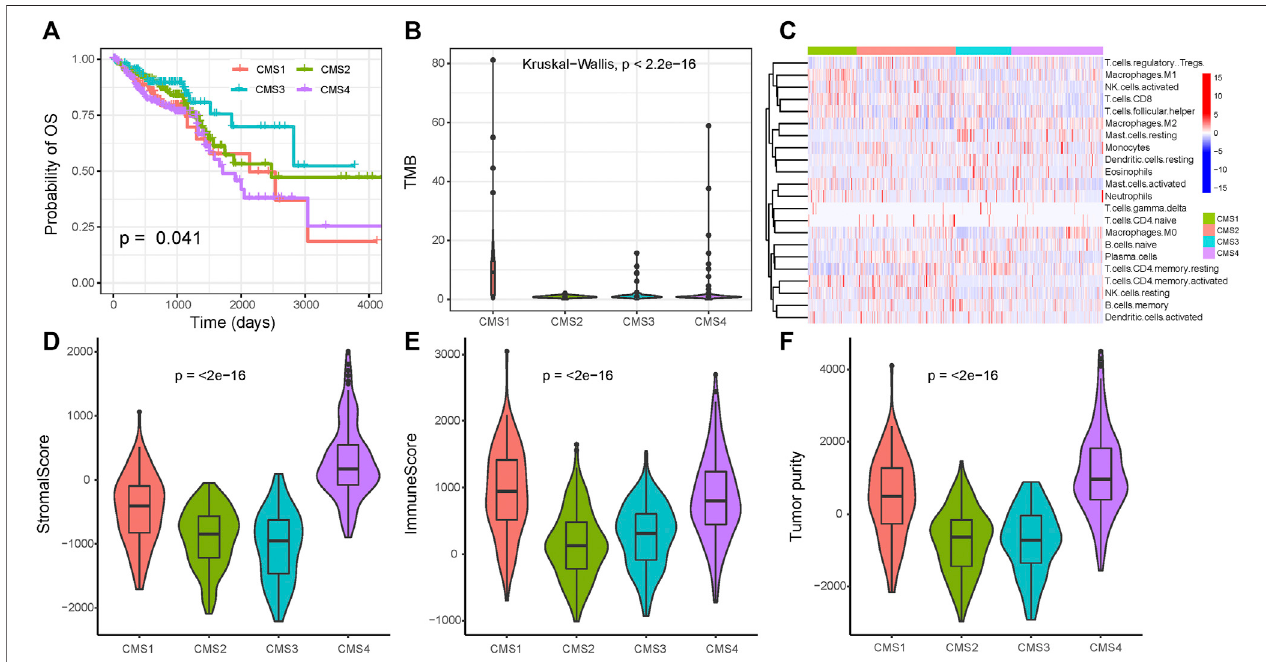
FIGURE4| Immune status amongthefour subgroups (A) OverallsurvivalforthefourCMS (B) Tumormutationburden amongthethreesubtypes (C) Immune-cell in fi ltration among the three subtypes (D – F) The immune microenvironment among the three groups.